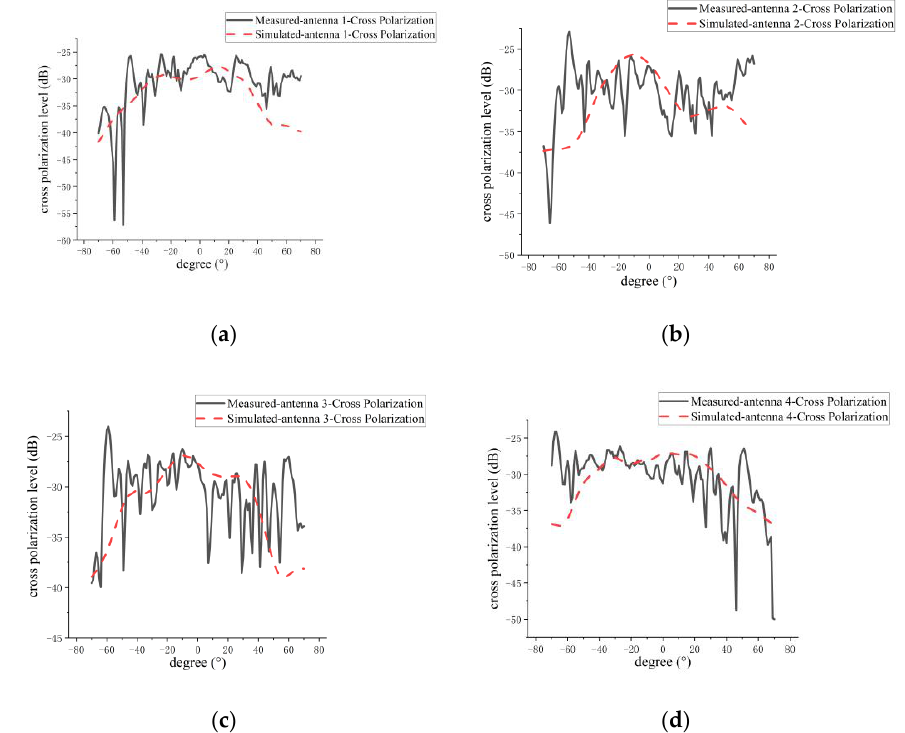
Figure 25. Comparison of measured and simulated E-plane cross-polarization patterns for every antenna element in sparse array: ( a ) grid antenna 1; ( b ) grid antenna 2; ( c ) grid antenna 3; ( d ) grid antenna 4.